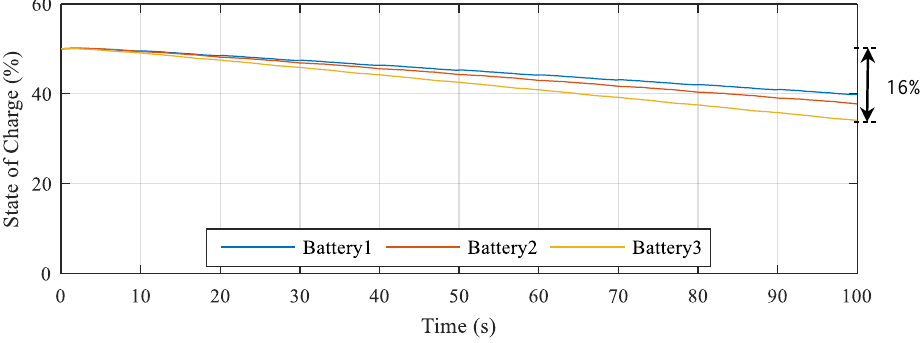
Figure 13. State of charge of batteries in the WECS without proposed controller (Case 2).